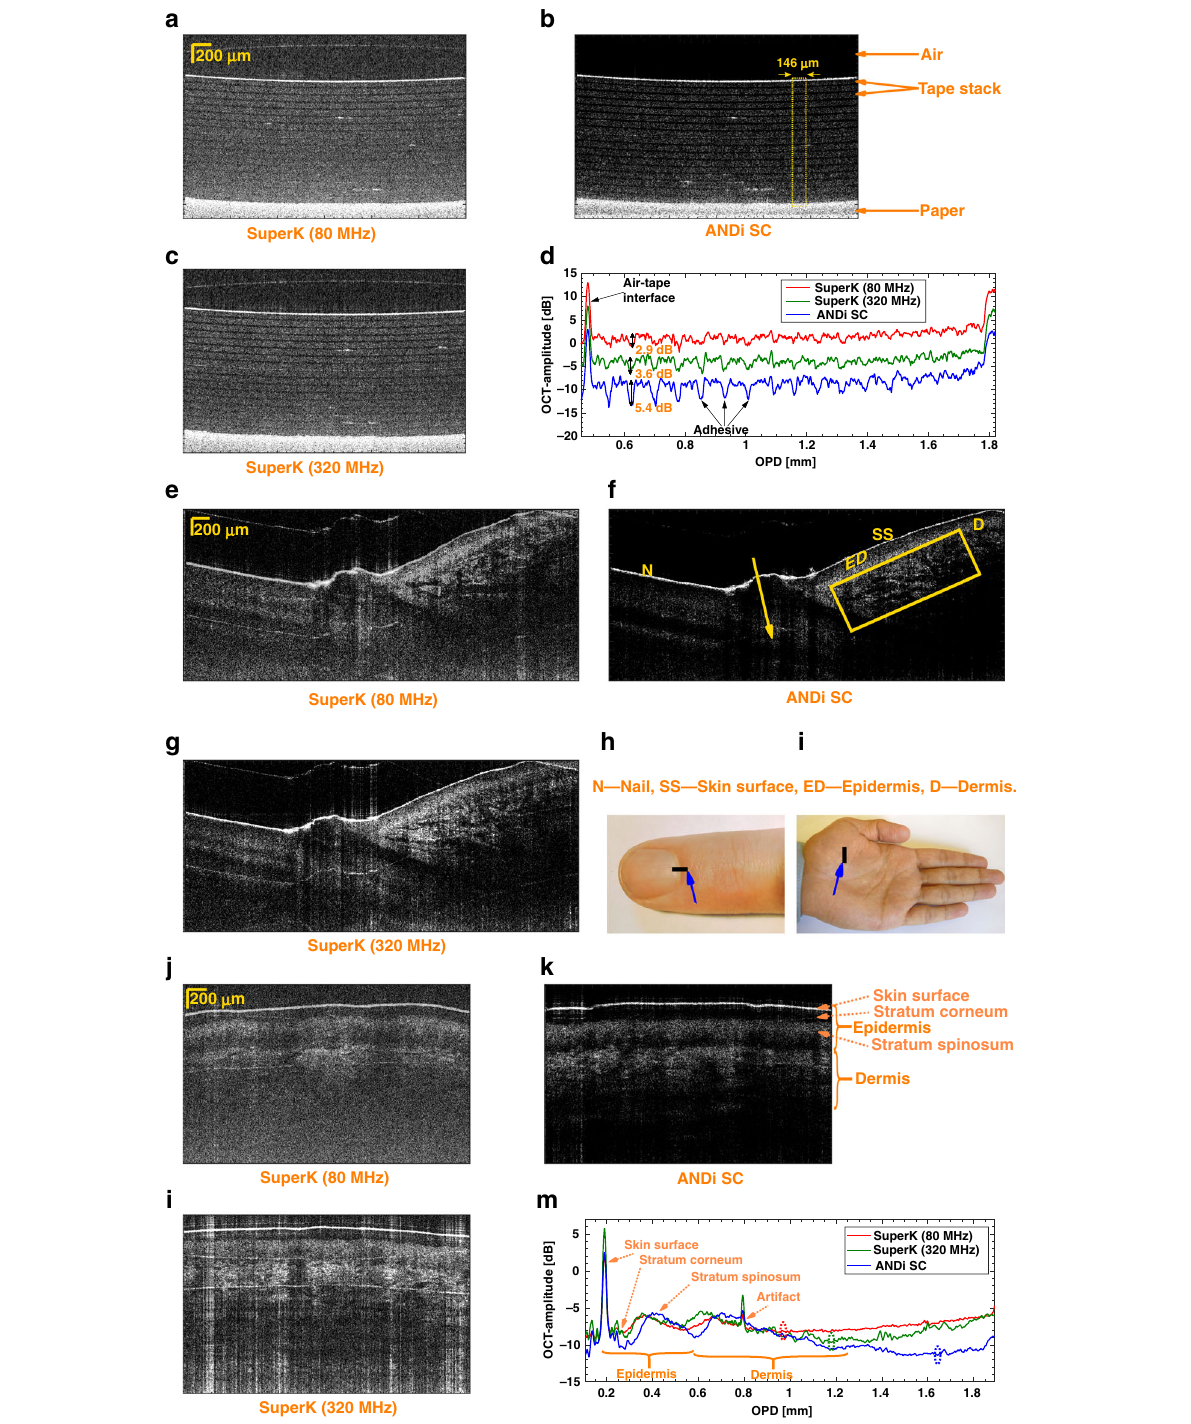
Fig. 3 OCT imaging of tape layers and a fi nger. Single B-scans of tape layers (2× 3mm), obtained using the 80MHz SuperK extreme ( a ), ANDi SC ( b ), and 320MHz SuperK extreme ( c ) sources. Averaged A-scans within the 146 μ m wide dotted box in ( b ) for the three sources offset by 5dB ( d ). The average is taken over 49 A-scans equally spaced within the dotted box. Single B-scans of a fi nger where the nail begins (2×4.5mm) [see photo ( h )], obtained using the 80MHz SuperK extreme ( e ), ANDi SC ( f ), and 320MHz SuperK extreme ( g ) sources. Single B-scans of the rough skin on a hand palm (2×3mm) [see photo ( i )] obtained using the 80MHz SuperK extreme ( j ), ANDi SC ( k ), and 320MHz SuperK extreme ( l ) sources. Averaged A-scan (averaged over entire B-scan, corresponding to 1024 A-scans) of the rough palm skin for the three sources ( m ). Dashed ellipses mark the penetration